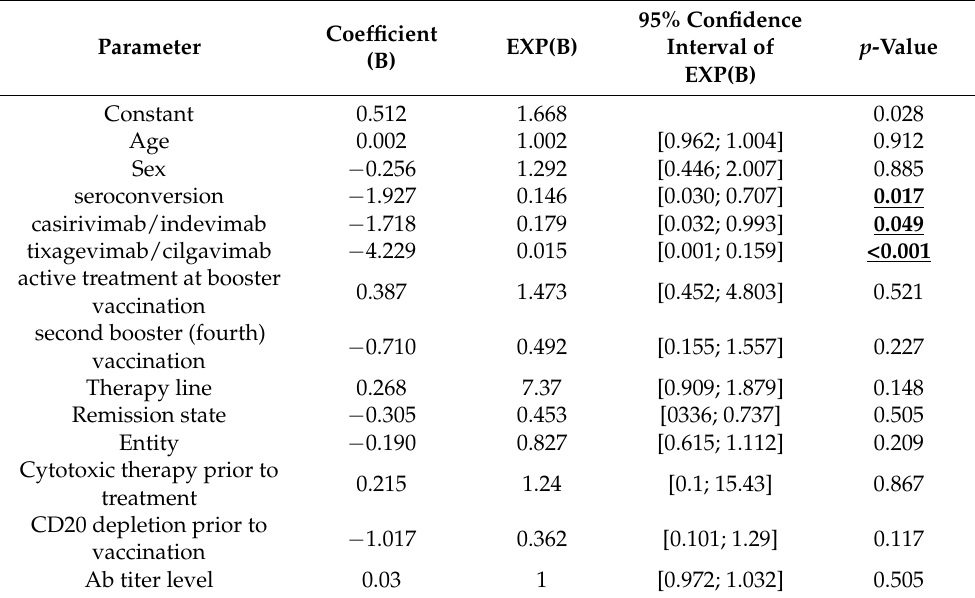
Table 5. Bivariable analysis of factors associated with COVID-19 after prime-booster vaccination in patients with hematologic